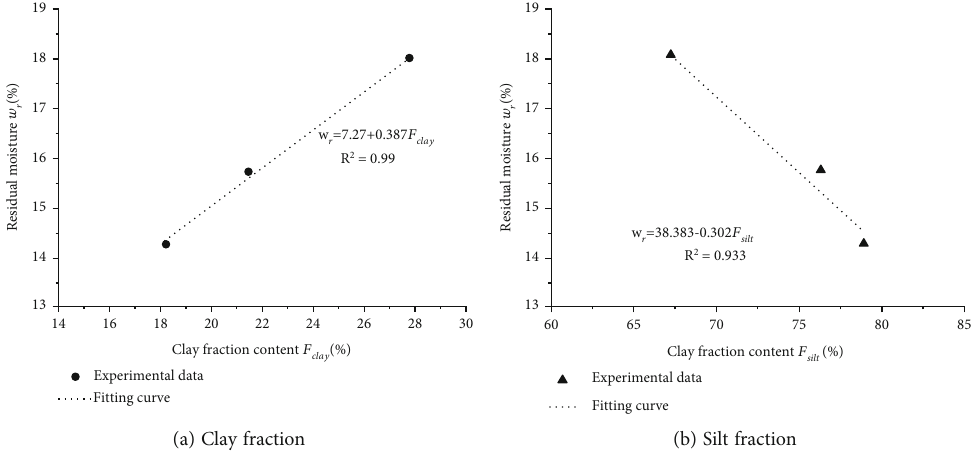
Figure 5: Relationship between residual water content and